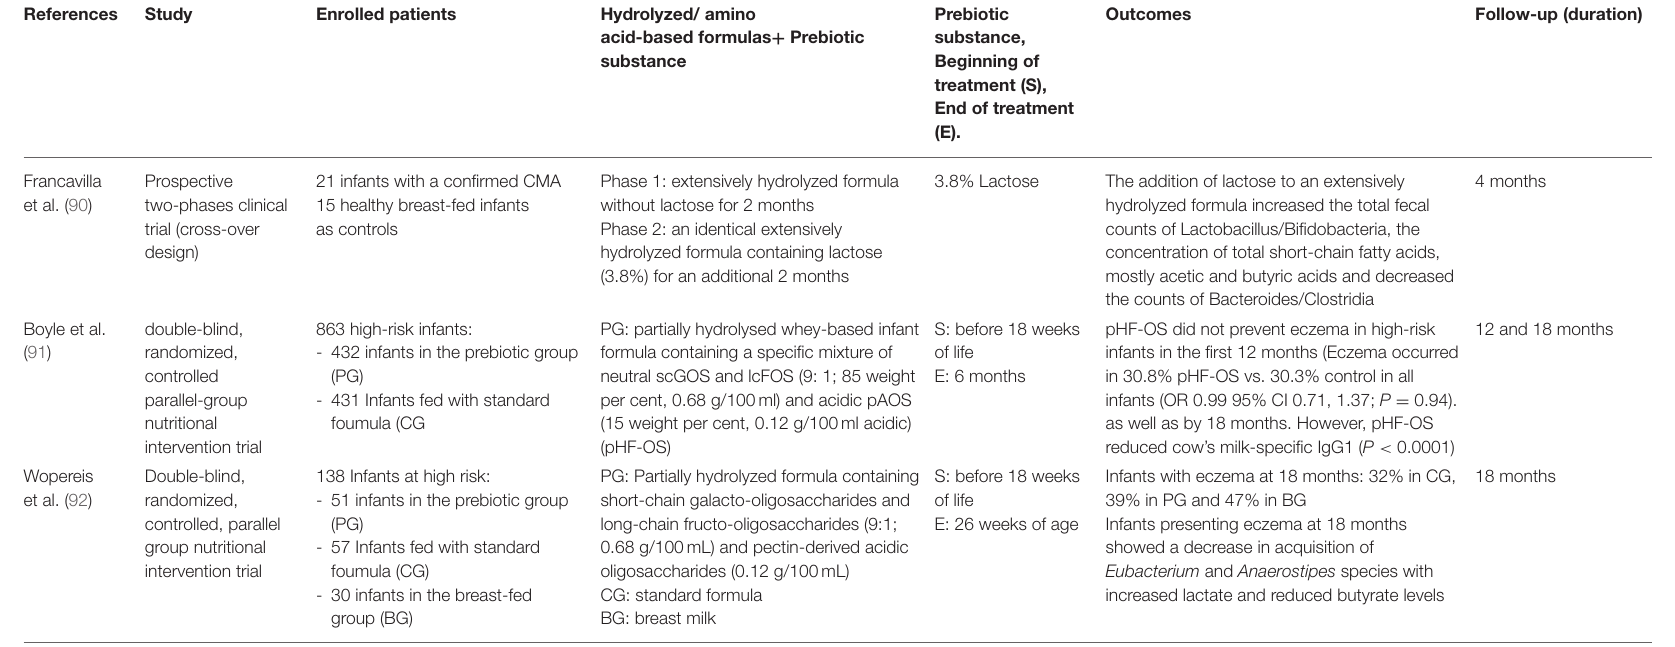
Standard formula (SF), Breast feeding